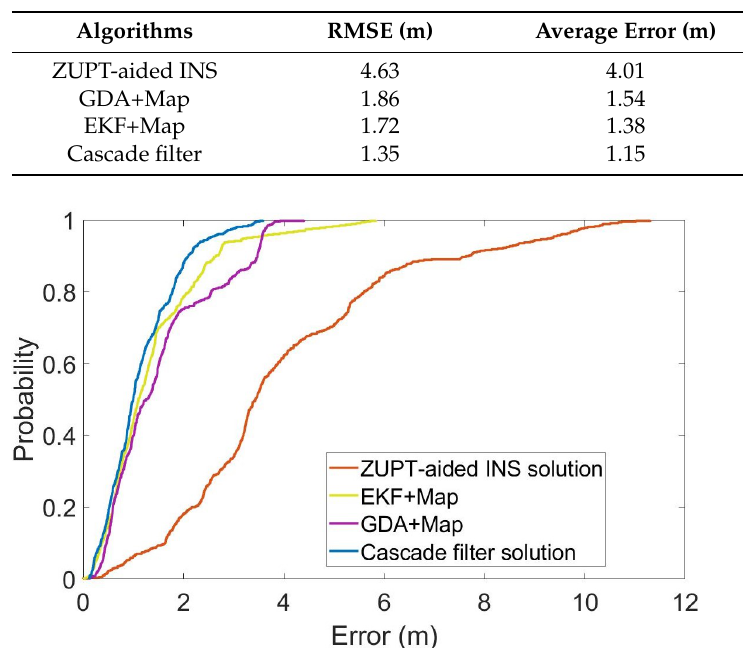
Figure 9. Statistical distribution of position